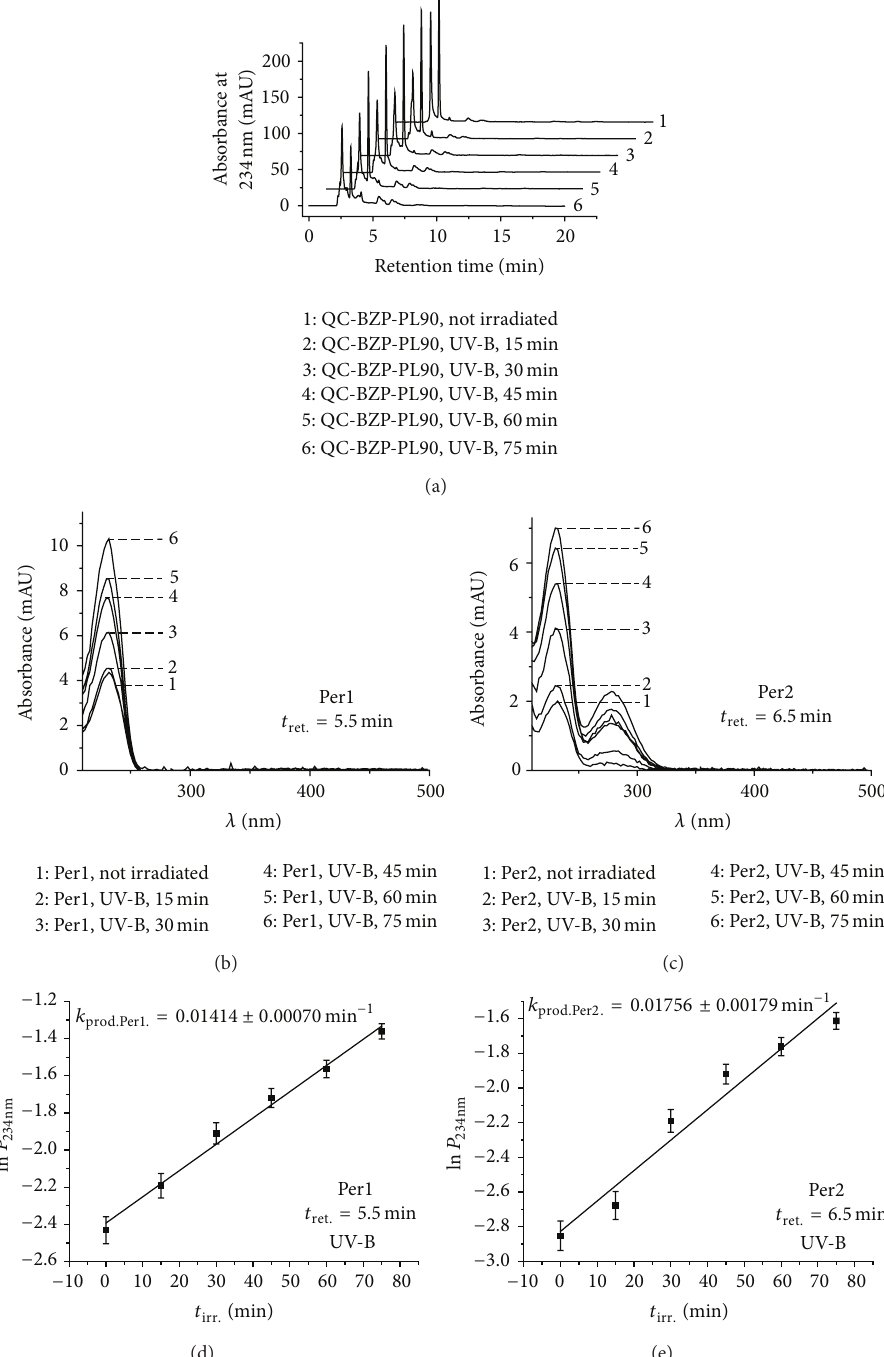
, of 5.5 and 6.5 min). ((b) and (c)) changes in the two ret . = 5.5 min, Per2 𝑡 = 6.5 min), as a result of the increasing ret . ret . = 5.5 min, Per2 𝑡 = 6.5 min) integrated ret . ret . = 𝑓(𝑡 ) . The corresponding rate constants and the related error bars nm irr .